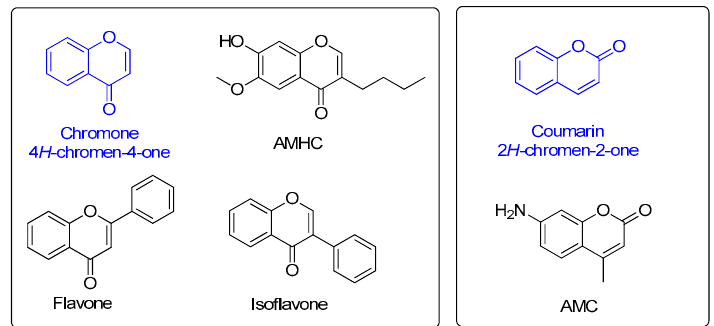
Figure 1. Chemical structures of chromenone derived compounds (chromone and coumarin). The left handside shows the structures of chromone and other chromone derived compounds, such as, flavones, isoflavone and 3-alkyl-6-methoxy-7-hydroxychromone (AMHC). The right handside shows the structures of coumarin and 7-amino-4-methylcoumarin (AMC).